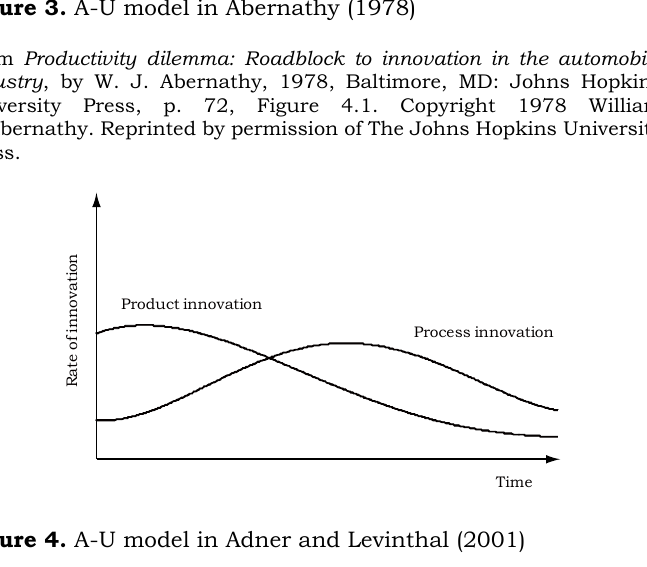
Figure 3. A-U model in Abernathy (1978)